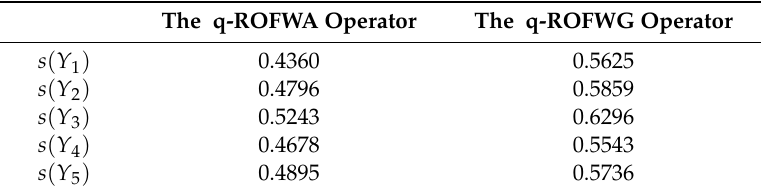
Table 7. The score values of Y i ( i = 1,2,3,4,5 ) . The q-ROFWA